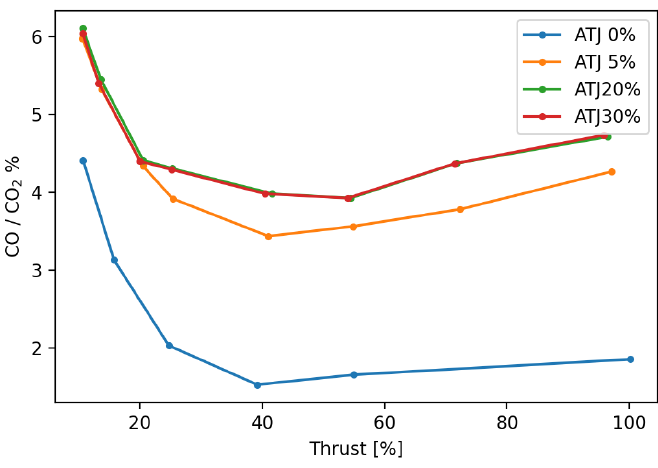
Figure 33. DGEN 380/ATJ: CO vs. CO 2